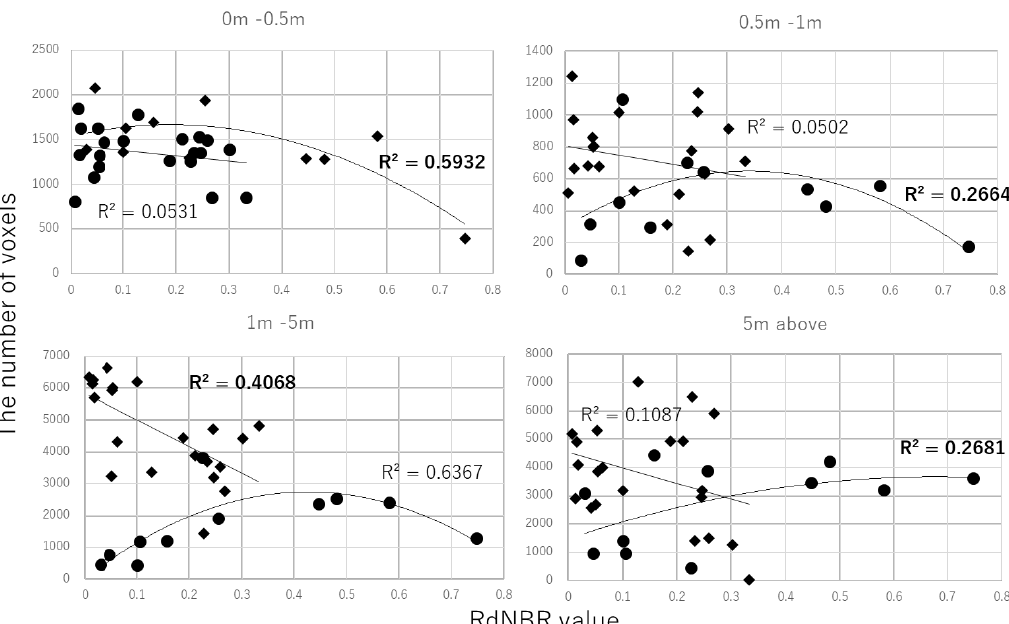
Figure 6. The relationship between RdNBR and the number of voxels at different heights or strata (marker ● : recently burned plot, ♦ : unburned plot, the bold fonts of R 2 values are statistically significant for the linear case and not-significant for the non-linear case with a significant level of 0.05).